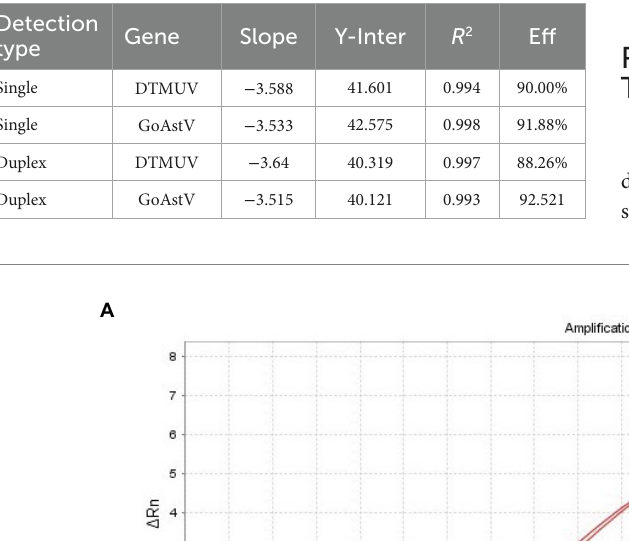
TABLE 2 Characterization parameters of standard curves for duplex TaqMan qPCR.